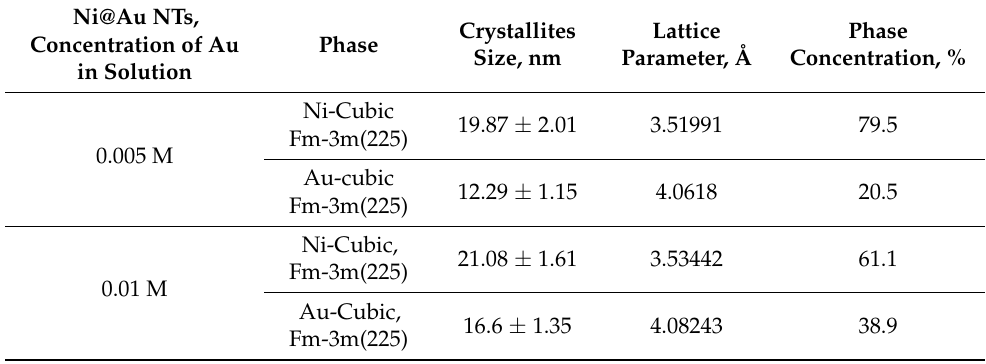
Figure 4. XRD of Ni@Au NTs with two concentrations of 0.005 M (bottom curve) and 0.01 M (upper curve). The lower intensity peaks are due to smaller amount of NTs used for the investigation. Table 2. Structural parameters of Ni@Au nanotubes.